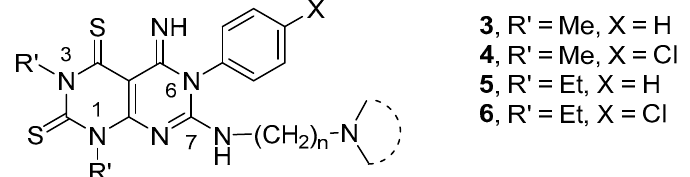
Figure 2. Chemical structures of pyrimido-pyrimidine derivatives 3 – 6 .